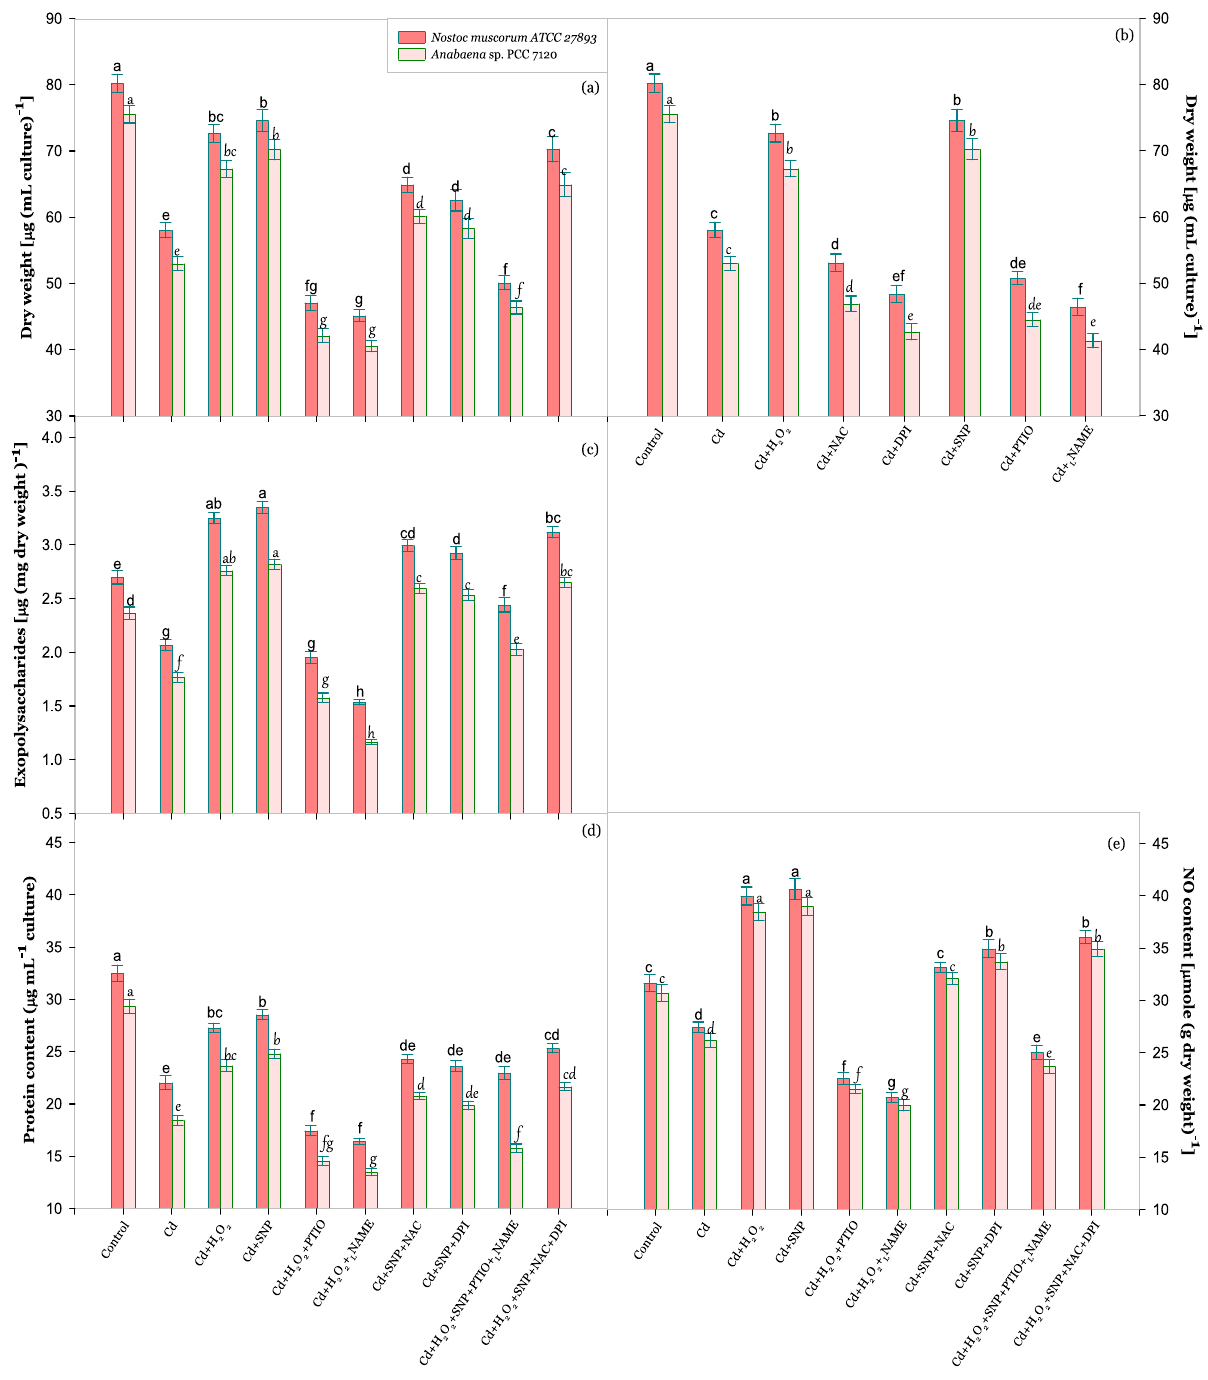
Figure 1. Effect of H 2 O 2 and NO (SNP) on growth (a,b) and contents of exopolysaccharides (c) , protein (d) and endogenous NO (e) of Nostoc muscorum ATCC 27893 and Anabaena sp. PCC 7120 exposed to Cd after 24 h of treatment. Data presented are means ± standard error of three independent experiments with three replicates in each experiment (n = 9). Bars with different letters represent significant difference at P < 0.05 significance level according to the